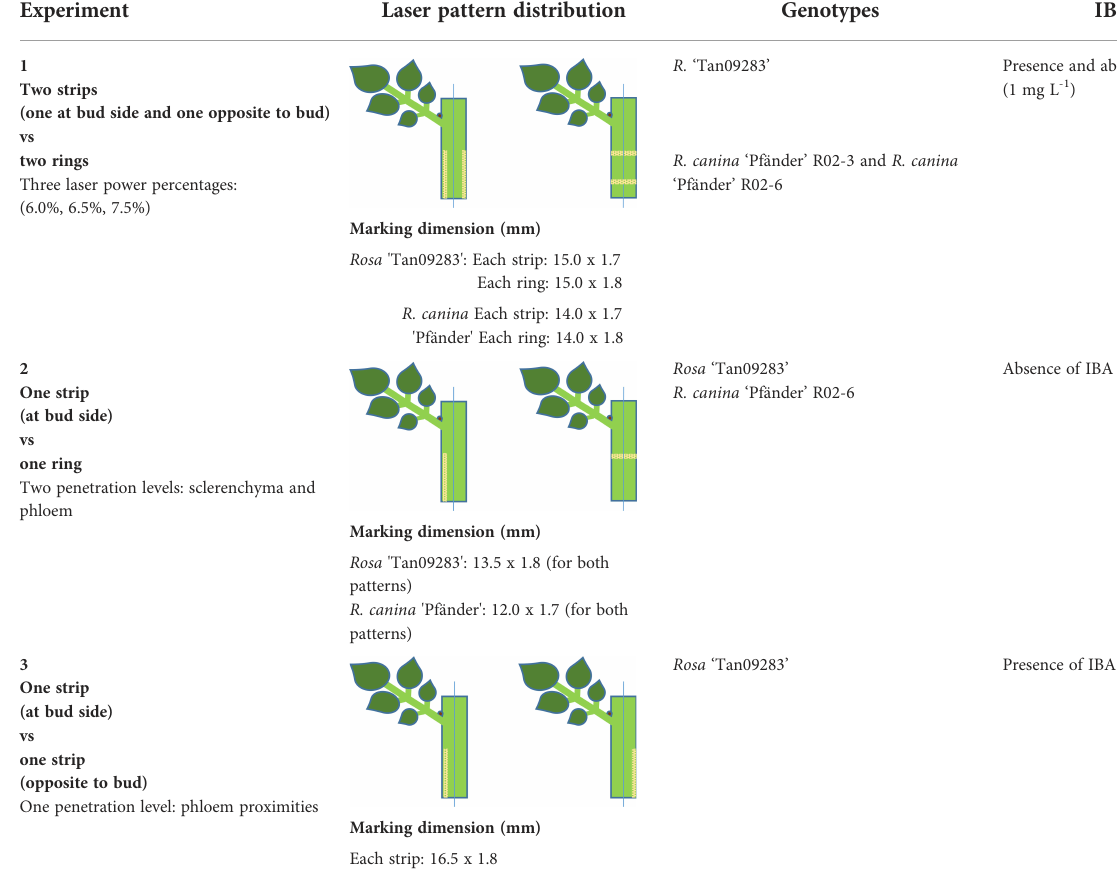
TABLE 1 Setup and laser marking patterns on rose leafy stem cuttings of the three experiments.